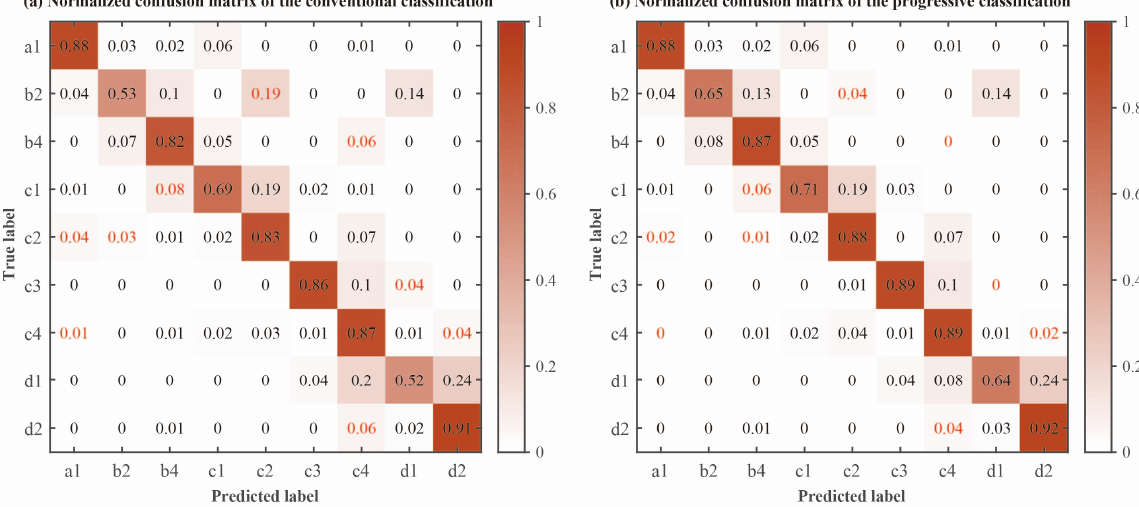
Figure 9. Confusion matrix of the conventional and progressive classification. The words on the axes are interpreted as follows: Qh ml : a1 plain fill; Qh apl : b2 clay; b4 broken stone soil; Qp 3 -Qhz: c1 silt; c2 clay; c3 sand; c4 broken stone soil; K 2 g: d1 gypsum–salt mudstone; d2 sand–mudstone interbedding.